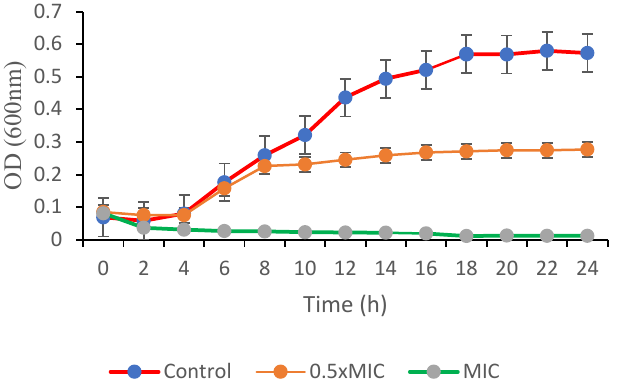
Figure 3. Kinetics of action of the GEO against B. glumae. The growth was recorded by quantifying the absorbance (O.D) at 600 nm hourly for 24 h. The error bars represent the standard deviations of three measurements.